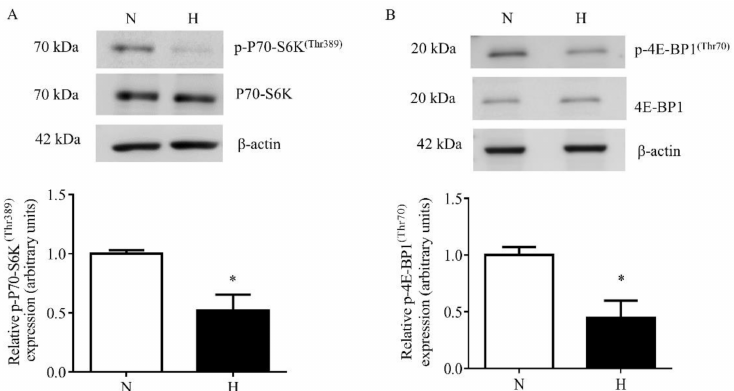
Figure 2. The effect of hypoxia on mTORC1 signaling in decidualized primary HESCs. Representa- tive Western blot of p-P70–S6K (Thr389) ( A ) and p-4E-BP1 (Thr70) ( B ) using cell lysates from decidualized primary HESCs cultured under control normoxia (N) (incubator air) or hypoxic (H) (1% O 2 ) condi- tions. Equal amounts of protein from cell lysates were used (30 µ g). Levels of phosphorylation were normalized to total protein and β -actin as the loading control. The Western blot data are summarized in the bar graphs ( n = 4). The data is represented as the mean + SEM; * p < 0.05 versus control is considered as per Student’s paired t